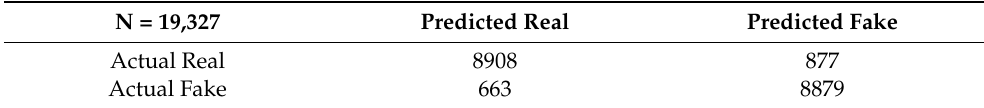
Table 7. Proposed model confusion matrix. N =